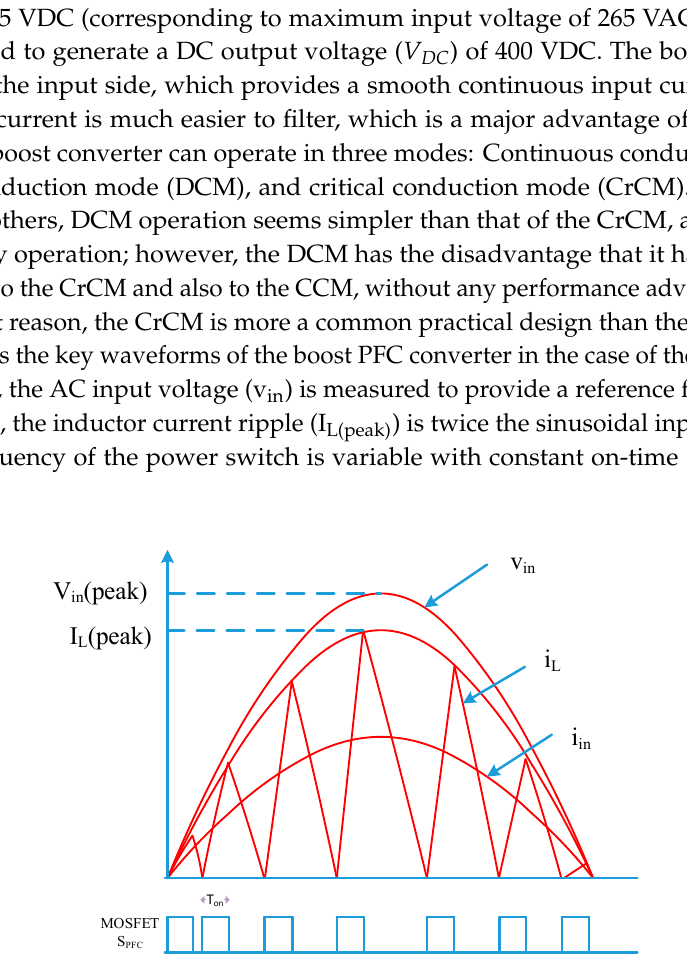
Figure 3. Key waveforms of the input voltage (v in ), input current (i in ), and inductor current (i L ) of the boost PFC .